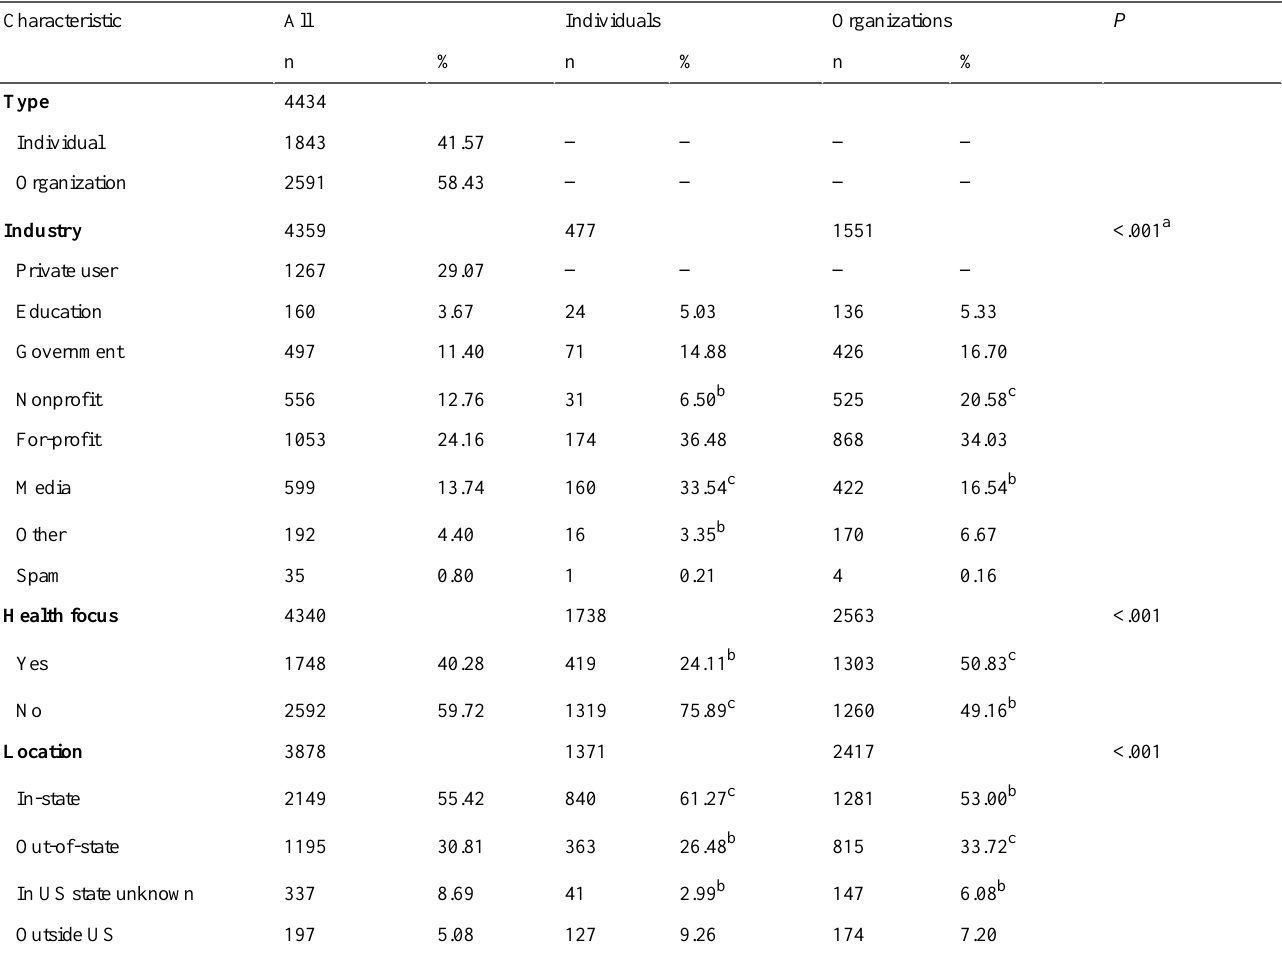
Table 1. Characteristics of local health department Twitter followers.